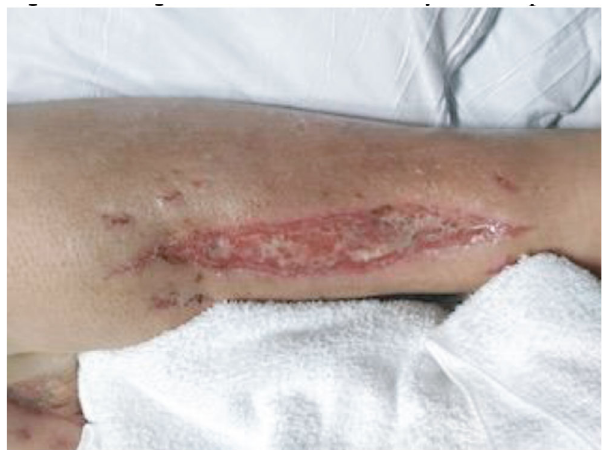
Figure 1: Image of cutaneous mucormycosis in patient 1 status postfasciotomy.